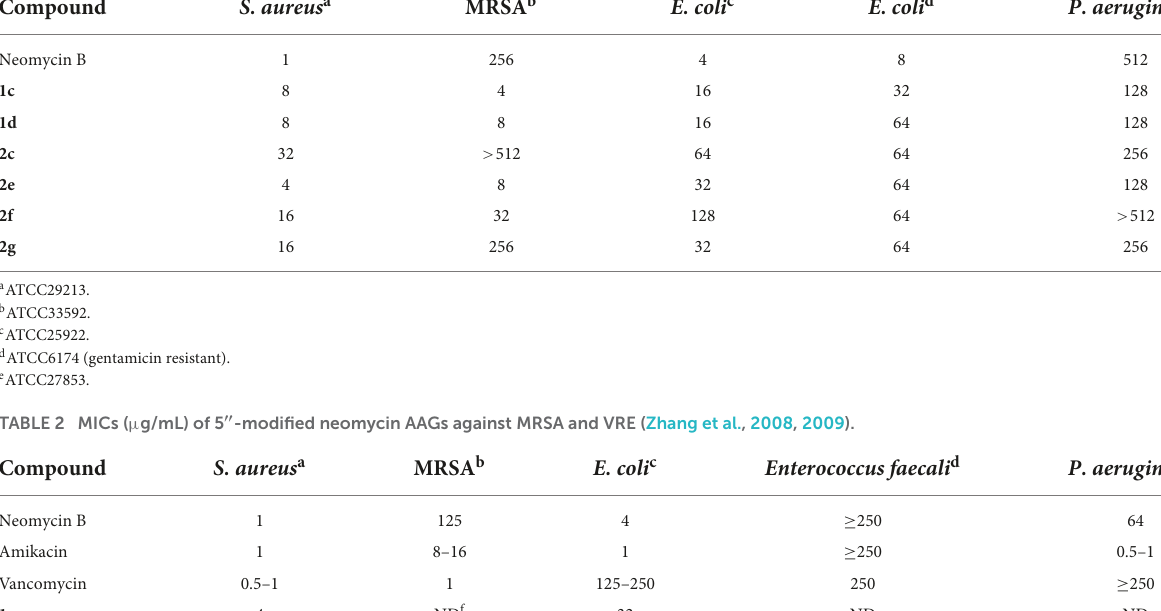
TABLE 1 MICs ( µ g/mL) of 5 (cid:48)(cid:48) -modified neomycin AAGs against MRSA (Bera et al., 2008, 2010a). Compound